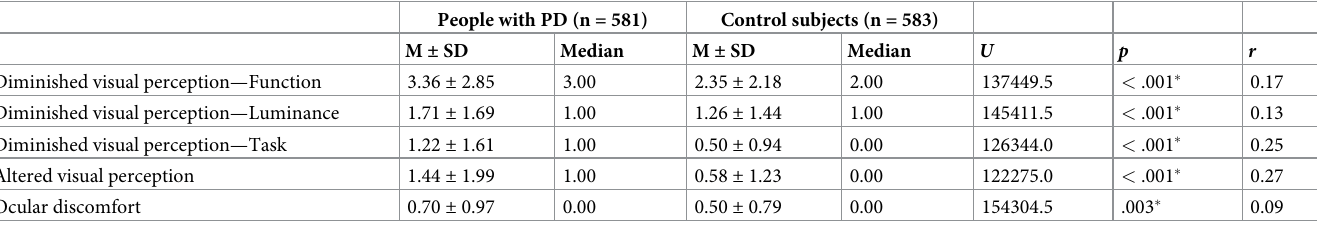
Table 5. Subscale scores of people with PD and the control group, with Mann-Whitney U test